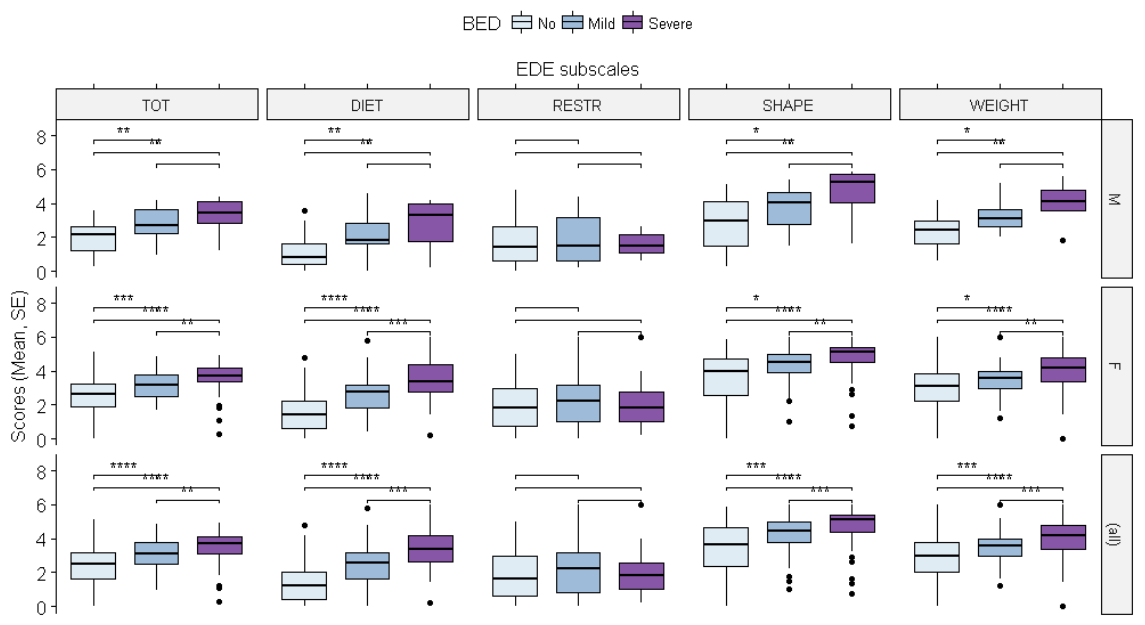
Figure 5. The effects of binge eating disorder severity and gender on the scores for the Eating Disorder Examination Questionnaire (EDE-Q). The differences between the groups were evaluated using the Wilcoxon test: weight-related concerns (severe: ß = 1.714, p = 0.0001; mild to moderate: ß = 0.764, p = 0.0183; female: ß = 0.741, p = 0.0002); body shape-related concerns (severe: ß = 1.900, p = 0.0002; mild to moderate: ß = 0.947, p = 0.0121; female: ß = 0.959, p = 0.00001); diet-related concerns (severe: ß = 1.756, p = 0.0001; mild to moderate: ß = 1.106, p = 0.0007; female: ß = 0.478, p = 0.0145). * = p < 0.05; ** = p < 0.01; *** = p < 0.001; **** = p < 0.000.